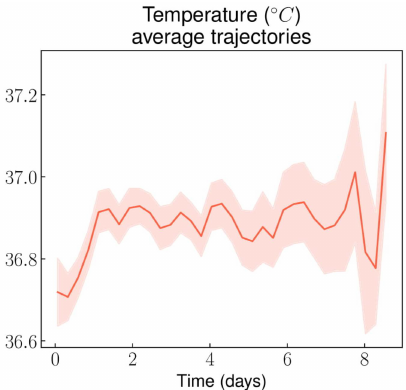
Figure 5. Temperature average trajectory throughout non-complicated VOC-related hospital